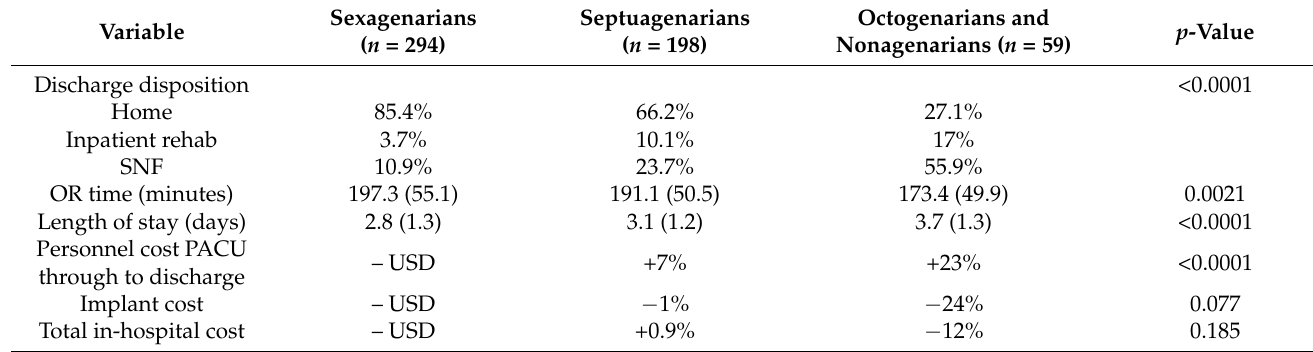
Table 4. Comparing the outcomes and costs for revision total hip and knee arthroplasties for sexagenarians,